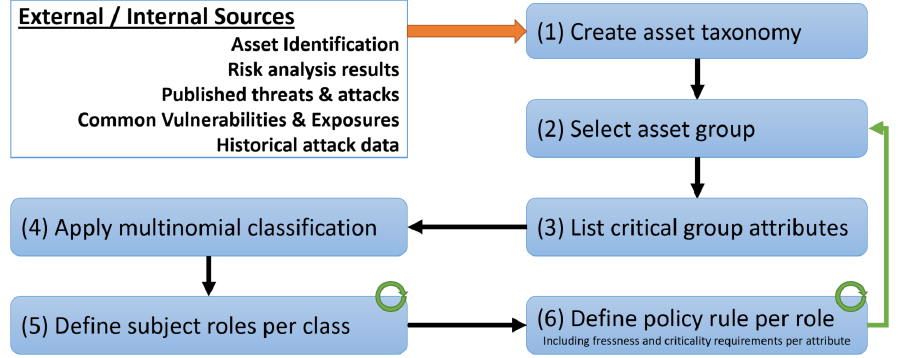
Figure 1. Process diagram for the initialization